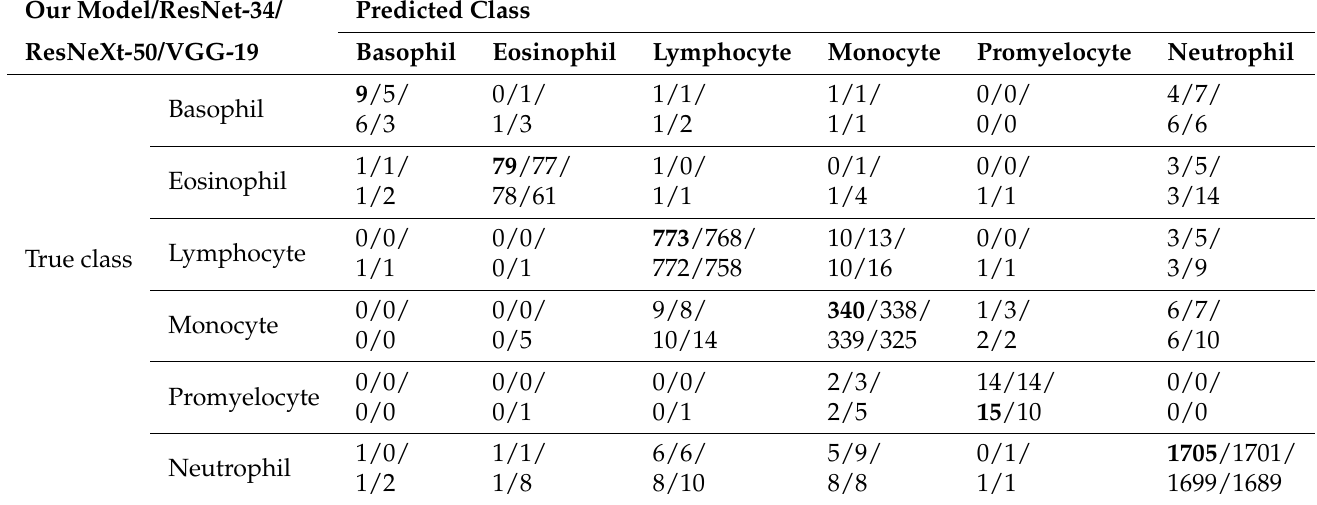
Table 7. The confusion matrix of the classification performance of the four models for the testing data of the APL- Cytomorphology_LMU dataset acquired by rounding off the mean value of five results of 5-fold cross-validation to the nearest whole number (e.g., 0.4 is 0, 0.6 is 1); each number represents the amounts of cells classified.